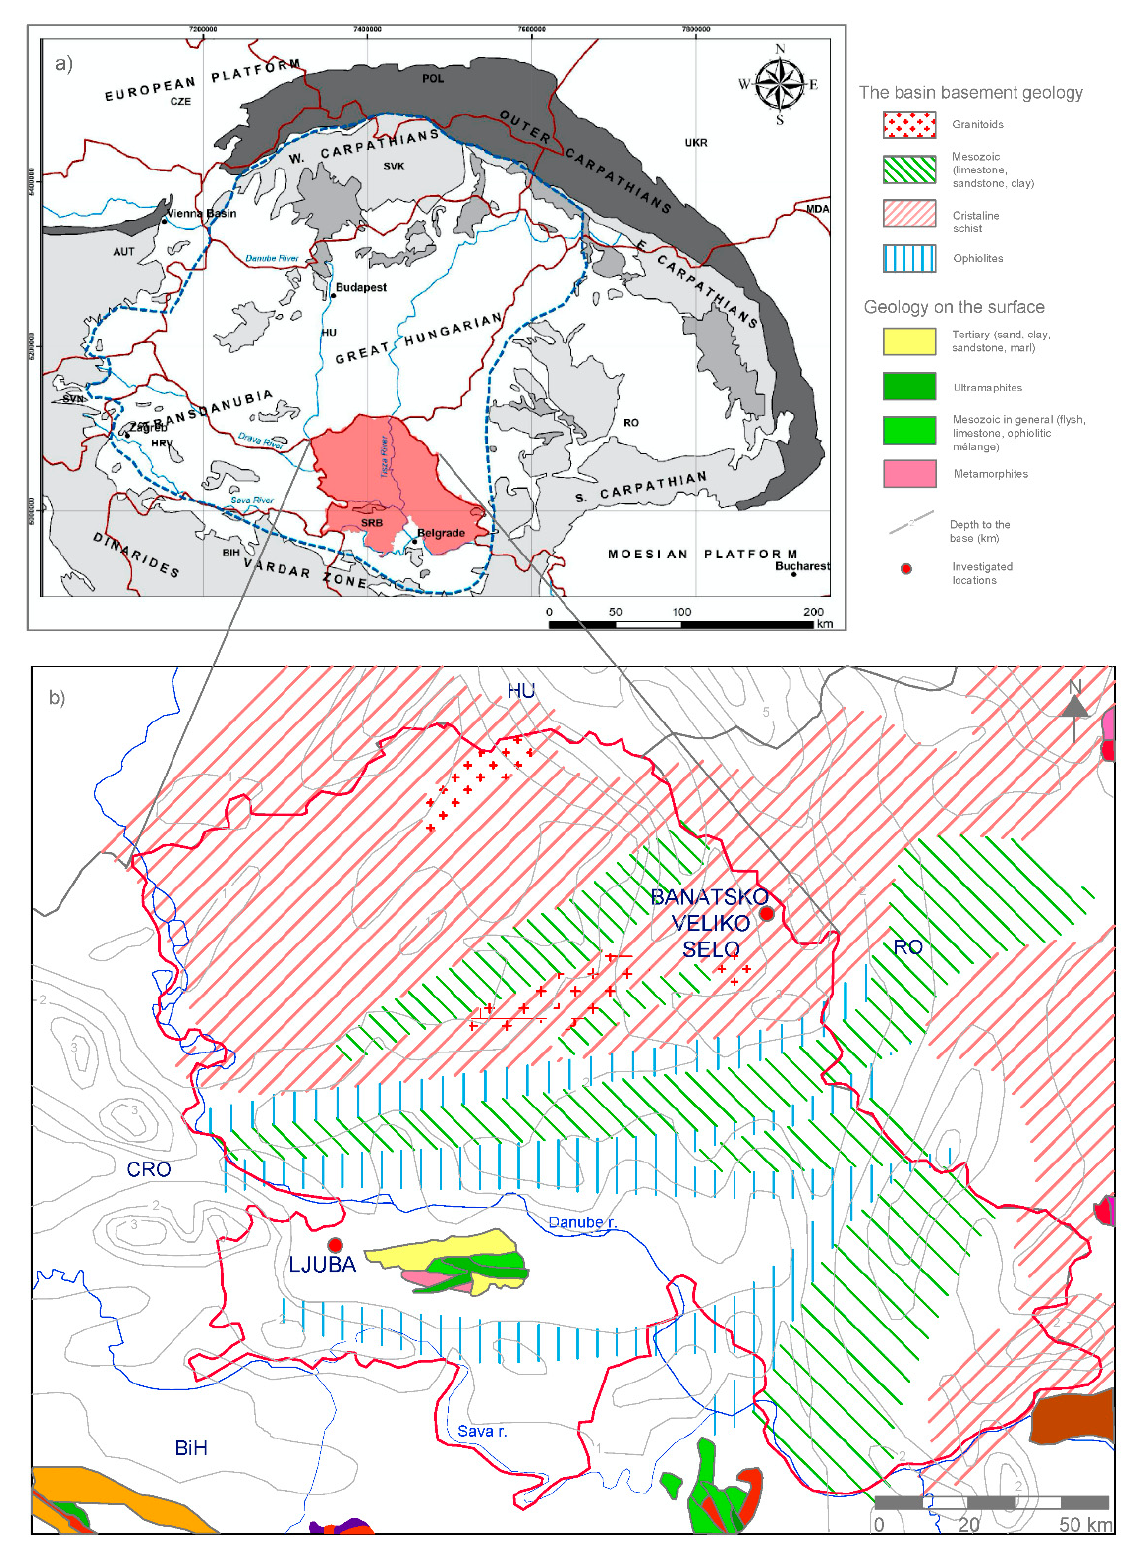
Figure 1. ( a ) Main tectonic units of the Alpine Fold Belt and Alpine–Carpathian–Dinaric Mountains (modified after [28]); ( b ) Geological map of the Vojvodina part of the Pannonian basin basement (modified after [29]).